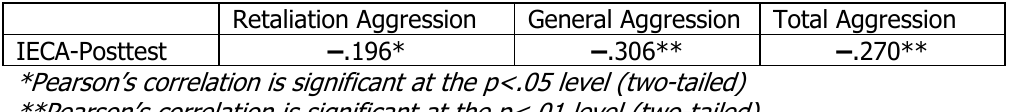
Pretest to Posttest Comparisons of NOBAGS and IECA Scores